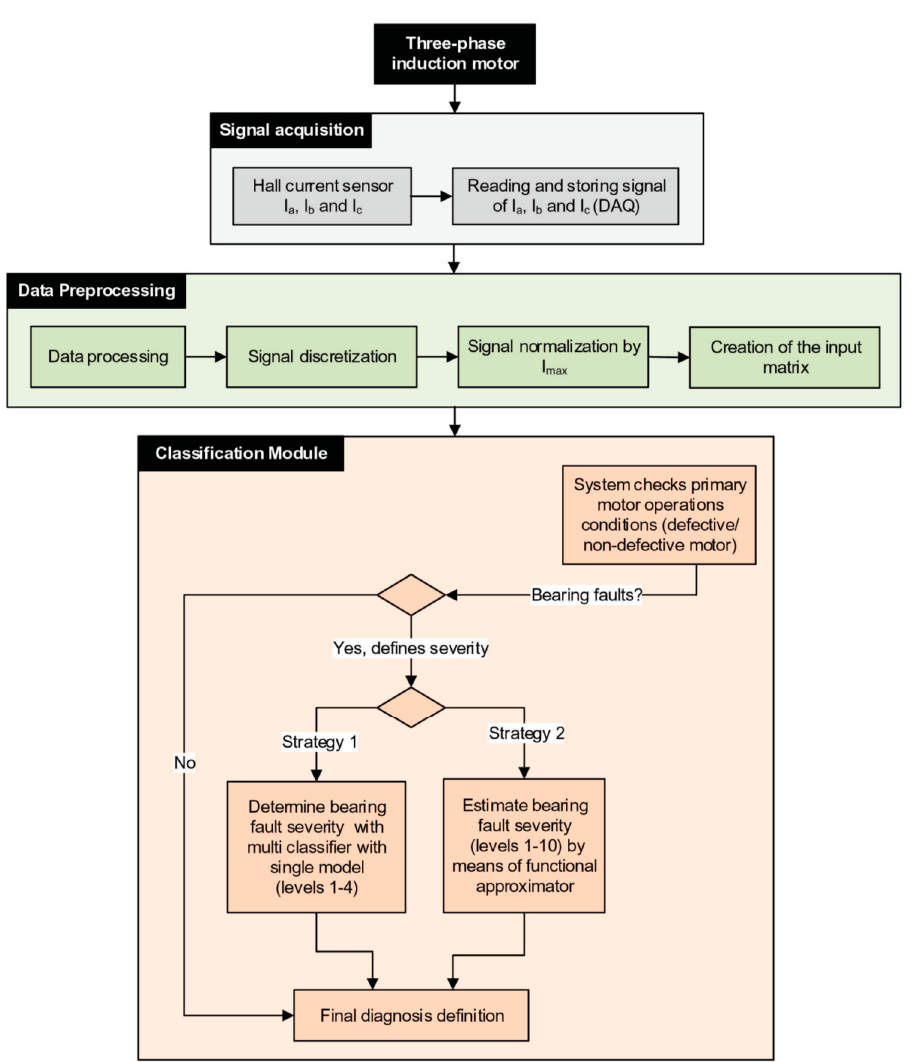
Figure 1. The functionality of the proposed diagnostic system.